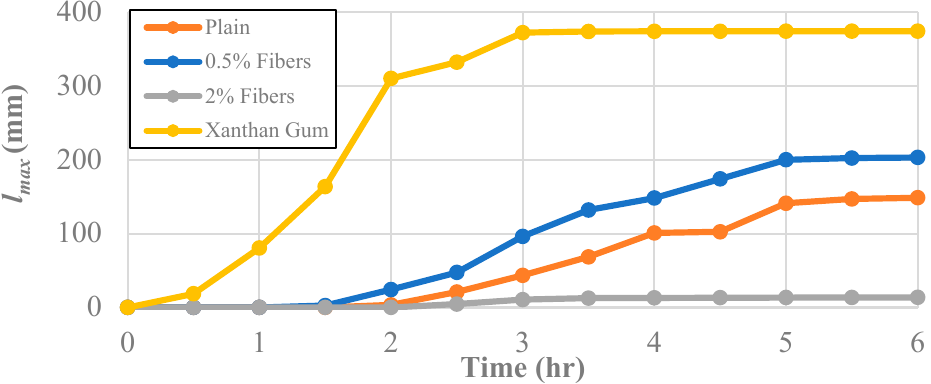
Figure 8. The effect of different additives on the maximum crack length, l max . The specimen treated with 0.5% fiber content developed a crack geometry with a slightly higher maximum crack length (203 mm) than the untreated clay. While the addition of the fibers did not dramatically change the crack width growth, the soils treated with the 0.5% fiber content promoted a more extensive crack network as seen in Figure 8. Boosting the fiber content added to 2% had a more dramatic effect on the soil’s performance than the maximum crack length. The introduction of more fibers led to a decrease in the maximum crack length by a factor of nearly 15, i.e., to 13.6 mm. Again, crack growth in those samples essentially ended after the three-hour mark, increasing by approximately 5 mm after that